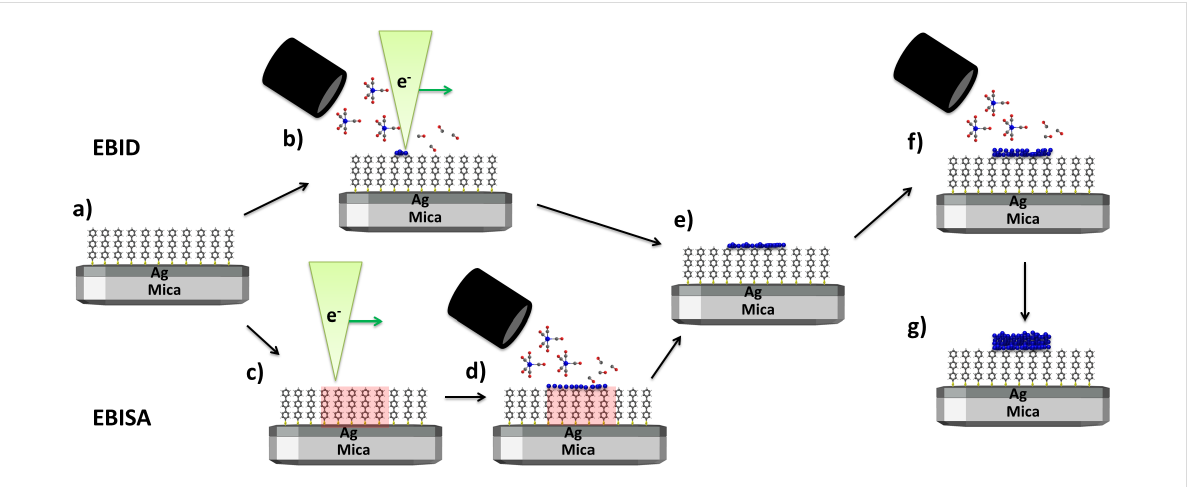
Figure 1: (a) SAM consisting of TPT molecules on a Ag(111)/mica substrate. (b) EBID process on the SAM Ag substrate. (c) Local activation of the TPT SAM with the focused electron beam within the EBISA process. (d) Precursor dosage after electron irradiation. If EBISA is possible the precur- sor dissociates locally on the activated sites. (e) Initial deposit that is formed by EBID respectively EBISA. (f) AG process that occurs on top of the initial deposit upon further precursor dosage. (g) Final well-defined nanostructure on top of a TPT on Ag(111)/mica